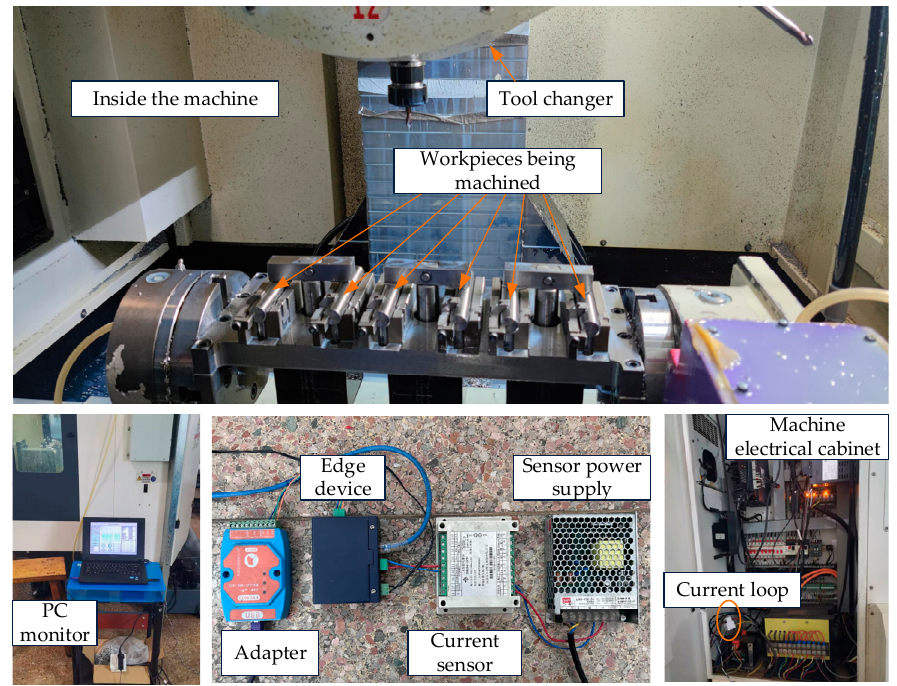
Figure 4. Experimental field equipment.